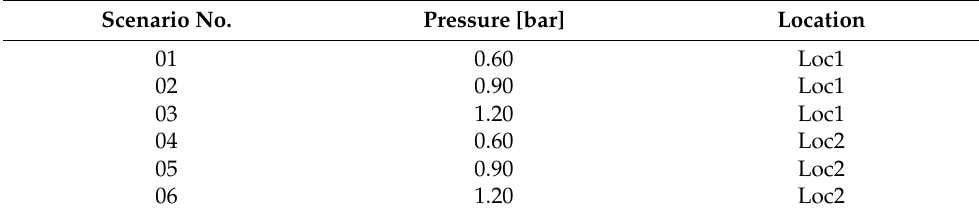
Figure 3. Illustration of the locations. ( a ) Position of Loc1, ( b ) position of Loc2. Table 2. Conditions of test scenarios.